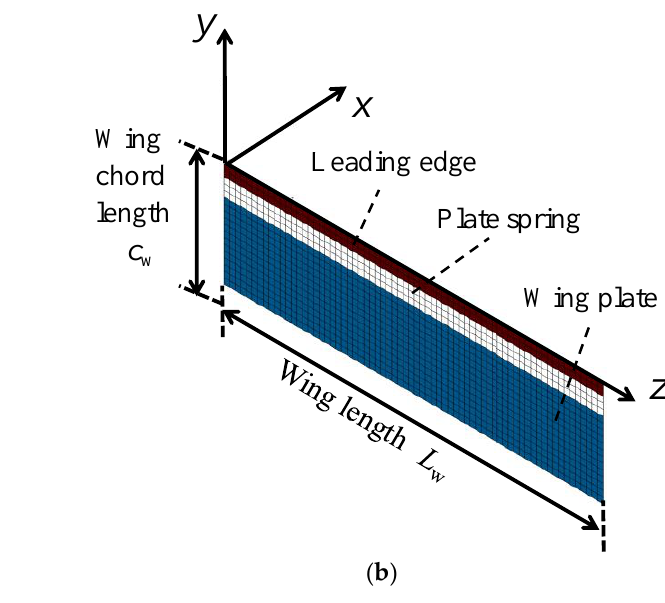
Figure 5. An implementation of the lumped torsional flexibility model using the rectangular wing and the plate spring: ( a ) Schematic view of the model; ( b ) The finite element model using shell elements. The number of shell elements is 1244, and the number of shell nodes is 1311.